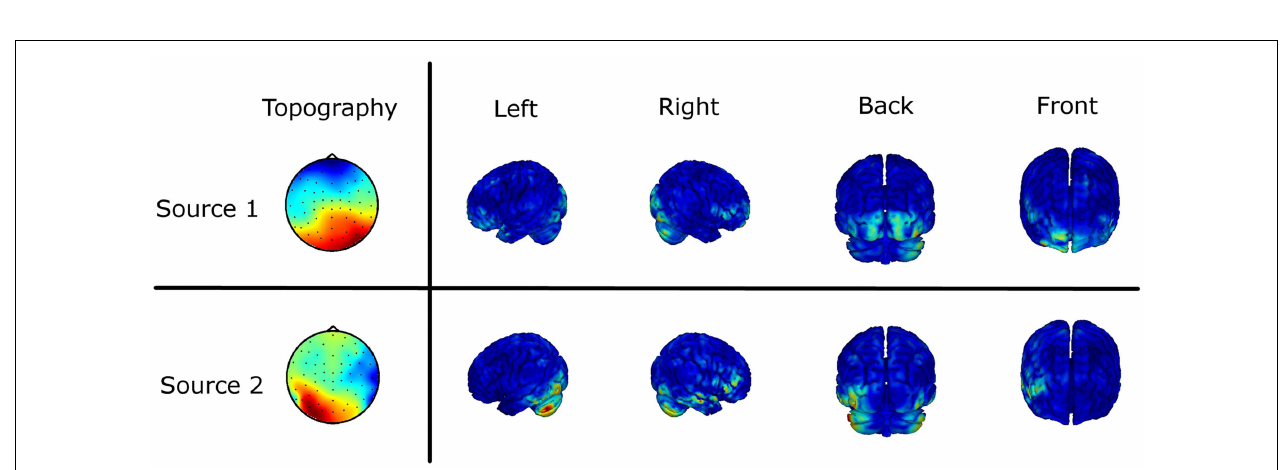
FIGURE 5 | Head-in-head plots for the imaginary part of coherency at 7Hz for the two conditions (top row) and for their difference (bottom left). The bottom right graph reports the FDR corrected p -values for the ImC